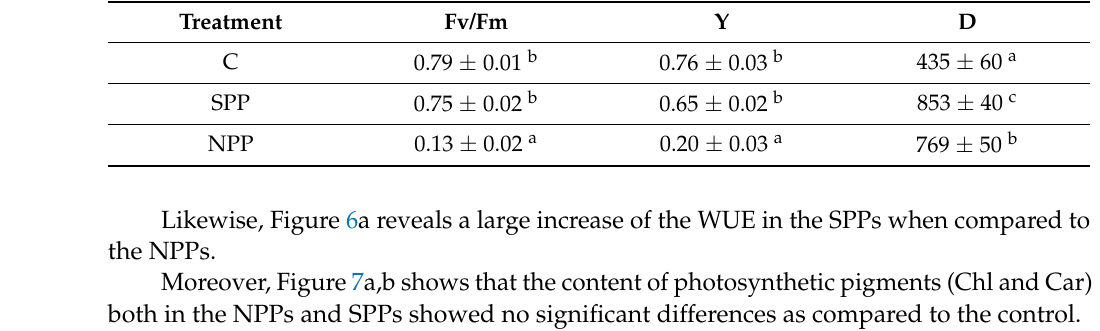
8 of 19 Table 1. Effect of cross-tolerance on maximum efficiency of PSII photochemistry, Fv/Fm, and effi-